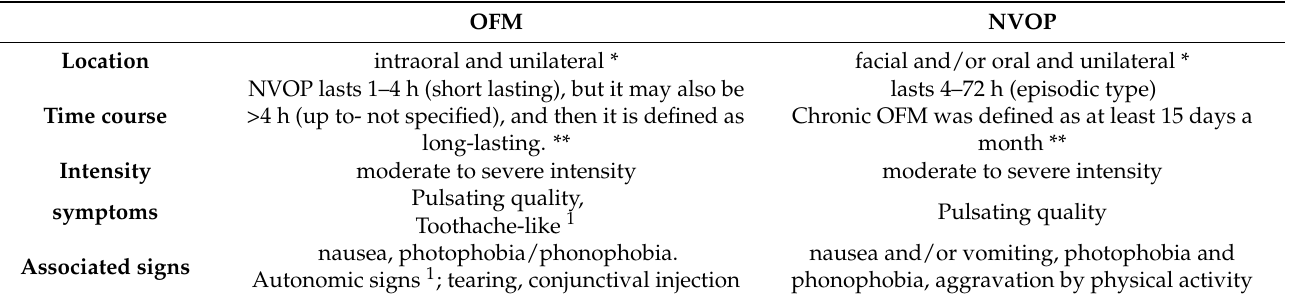
Table 5. Common or unique features for orofacial migraine (OFM) and neurovascular orofacial pain (NVOP). OFM intraoral and unilateral